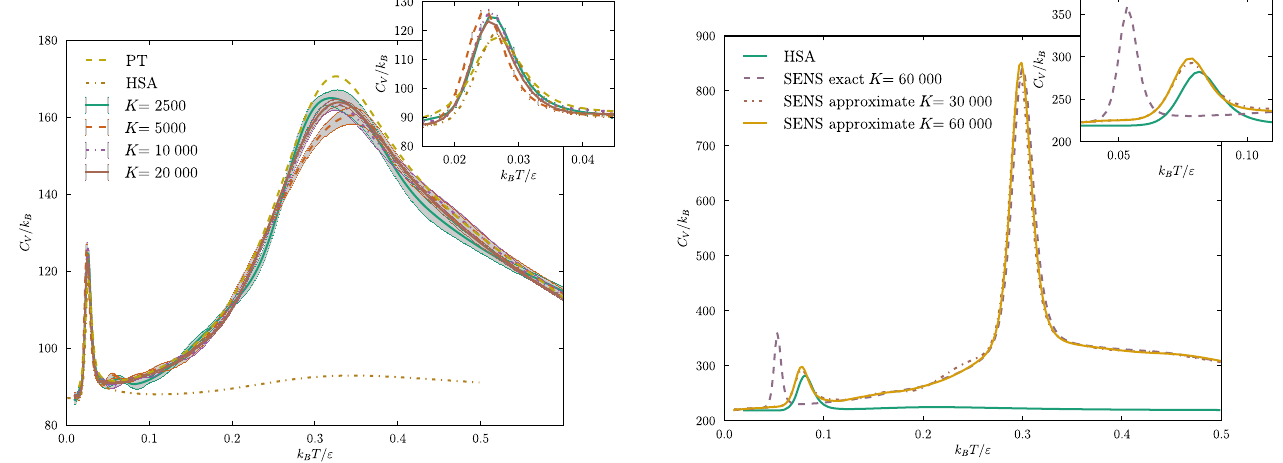
FIG. 2. Comparison of heat capacity curves for LJ 31 obtained by exact SENS using different numbers of replicas. The PT and HSA curves were obtained by parallel tempering and the harmonic superposition approximation, respectively.